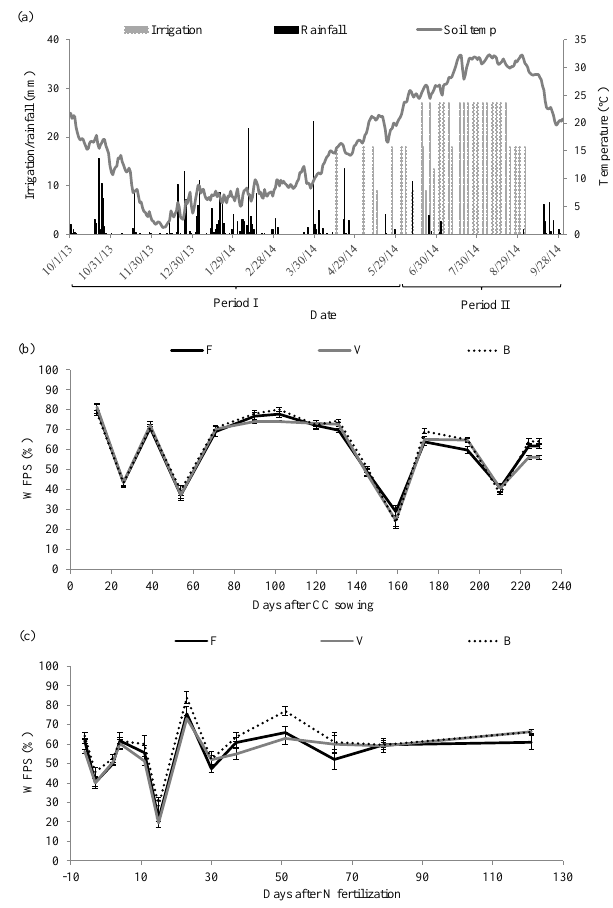
◦ C) rainfall and irrigation fig01 Figure 1. Daily mean soil temperature ( (mm) (a) and soil WFPS (%) in the three cover crop (CC) treatments (fallow, F; vetch, V; and barley, B) during Period I (b) and II (c) . Vertical lines indicate standard